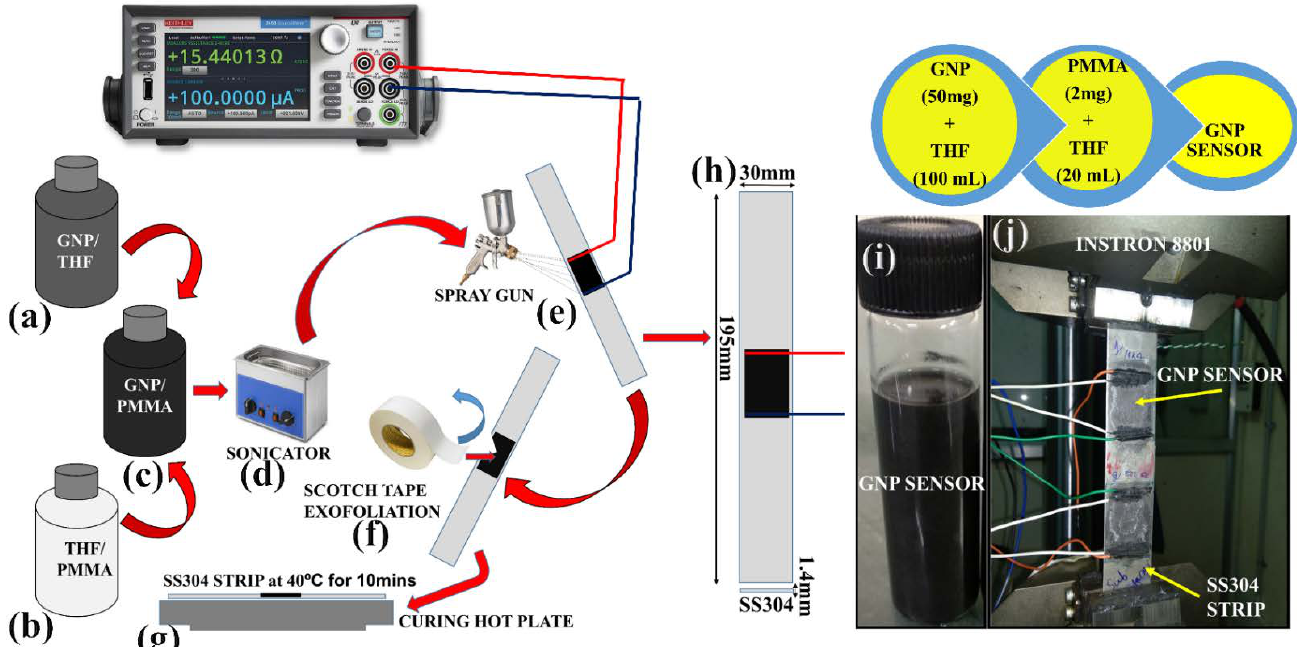
Figure 1. Experimental setup for smart GNPs/PMMA sensor: ( a – g ) Sensor preparation from ultra- sonication to spray-coating approach upon SS304 specimen; ( h ) SS304 specimen with geometrical dimensions (195 mm × 30 mm × 1.143 mm); ( i , j ) GNPs/PMMA spray-coated sensor for sensitivity test upon SS304 by UTM INSTRON (8801).